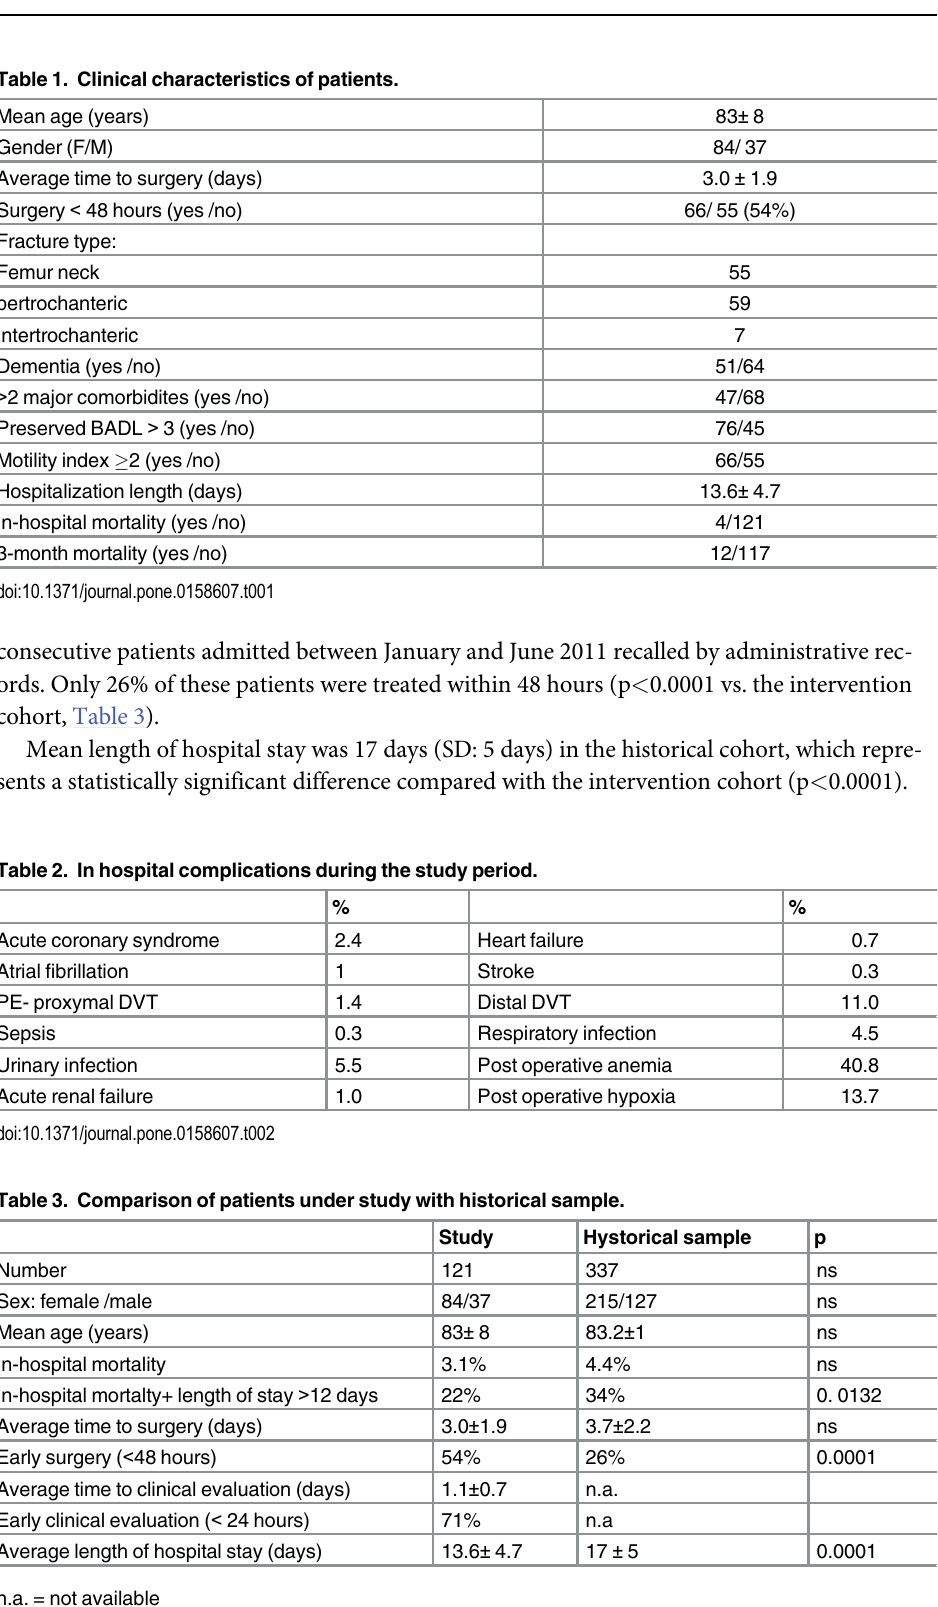
Table 1. Clinical characteristics of patients.